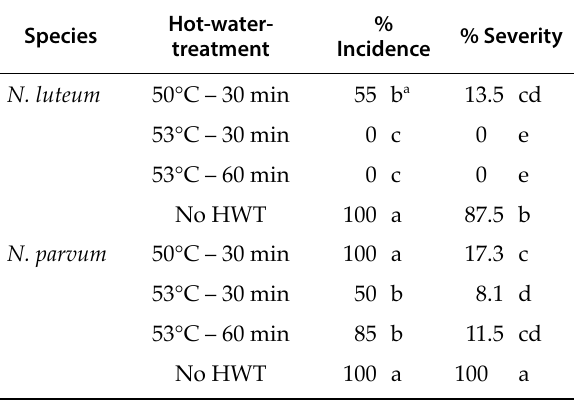
Table 2. Mean pathogen incidence and severity (extent of infection) in canes treated with different temperatures and times of hot-water treatments 1 week after being inoculat- ed with Neofusicoccum luteum and N.